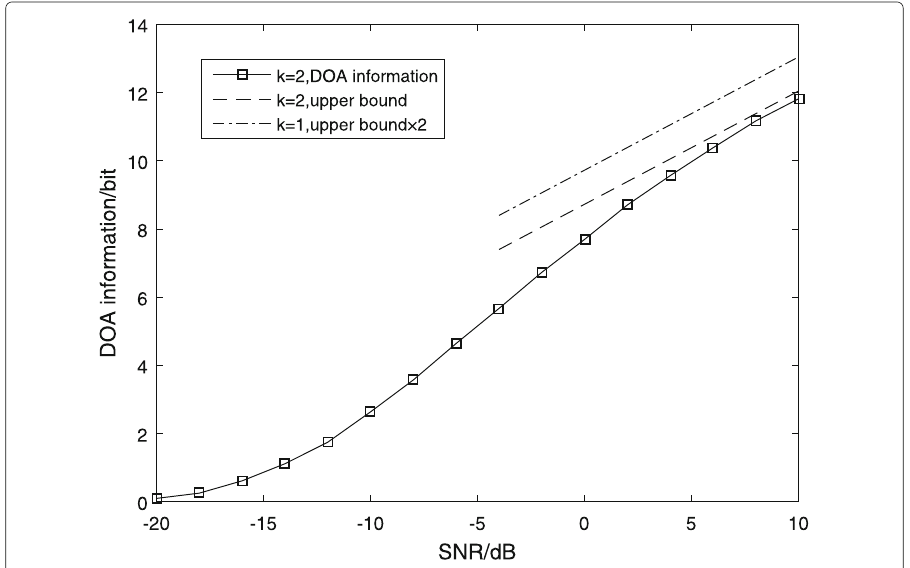
Fig. 4 DOA information in random amplitudes